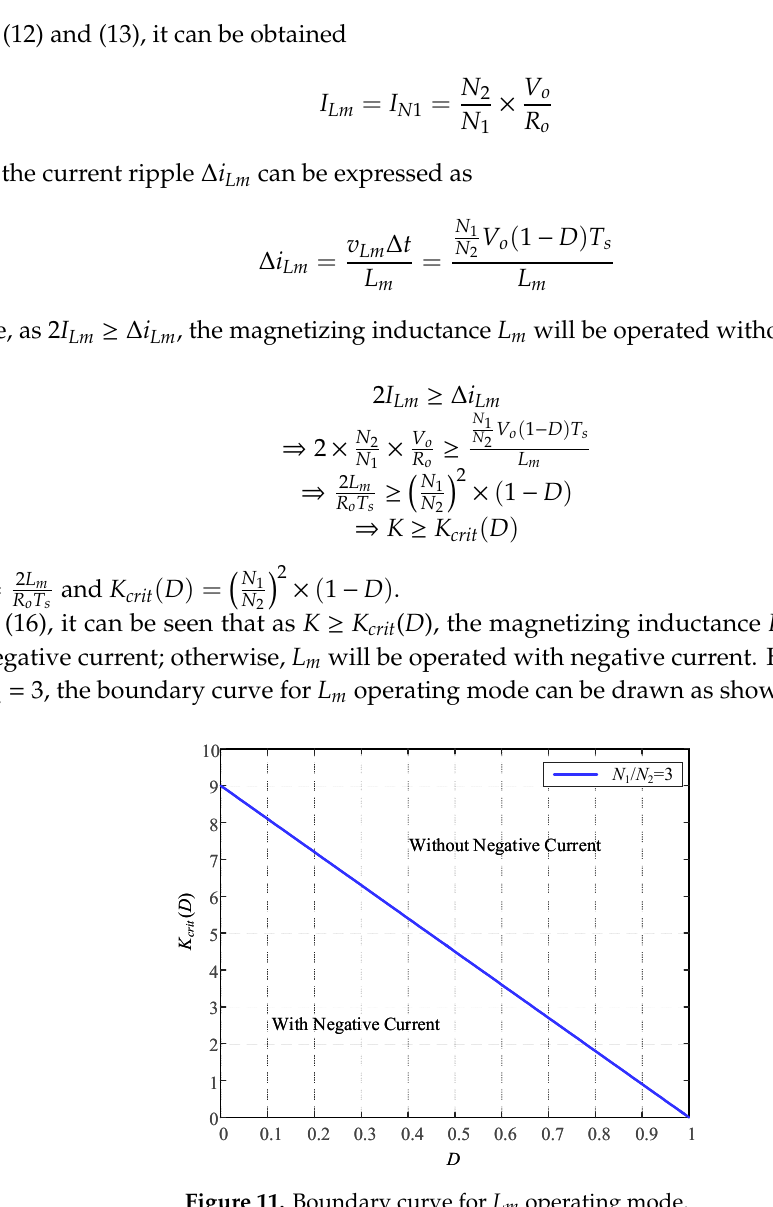
Figure 10. Equivalent model for the coupling inductor under DC analysis.